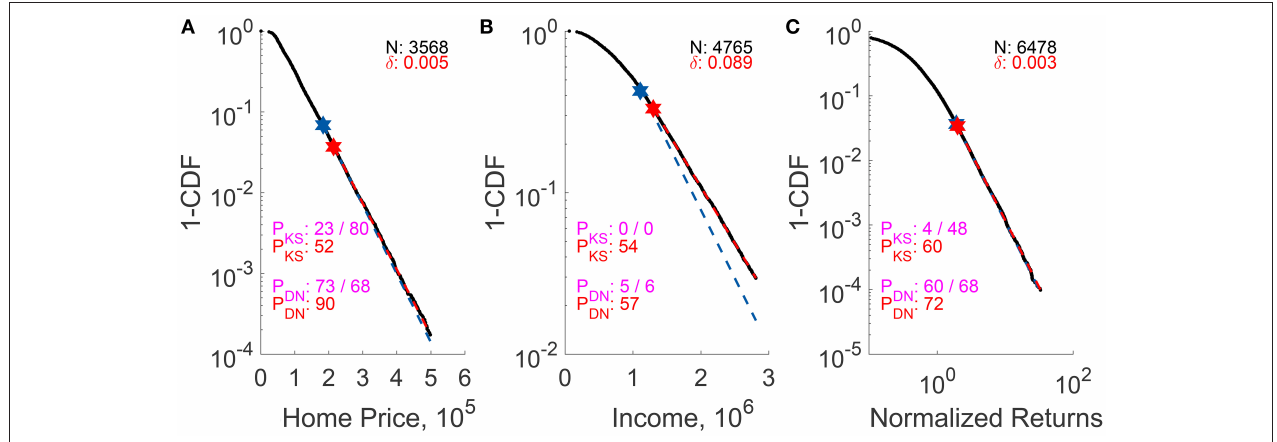
FIGURE 7 | p -testing results for (A) 2012–2014 Taiwan home price per square foot (fitted to EXP), (B) 2012 Taiwan lower-tail income (fitted to EXP), and (C) 2009–2016 Straits Times Index normalized return (fitted to PL) before and after finite-sample adjustments. In this figure, the N represent the number of fitted data, and the empirical CDF that is adjusted for FLE is shown as black dots, while the unadjusted and adjusted fits are shown as blue and red dashed line respectively. P KS / DN -values (in percentage) are for unadjusted (blue) and adjusted (red) fits. We separate the p -values obtained using the CSN method (left) from those using Equations (22) or (23) (right) by a “ /